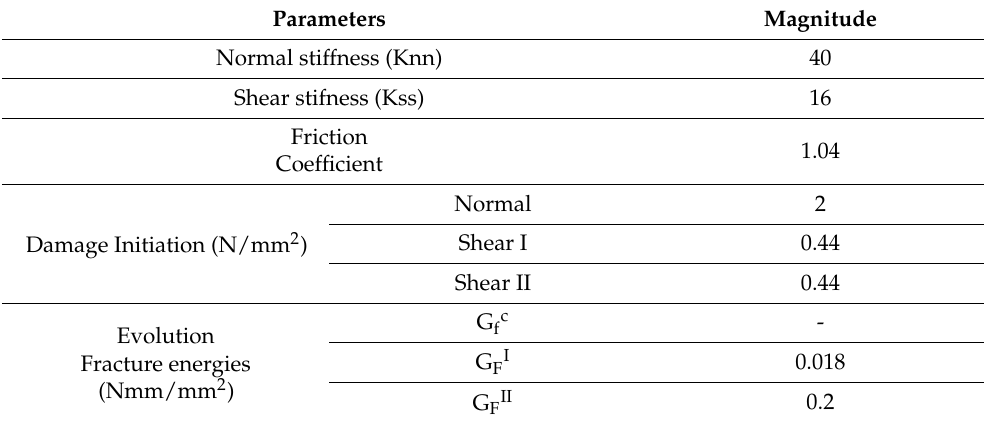
Table 7. Mechanical properties of brick–mortar interface (contact cohesive